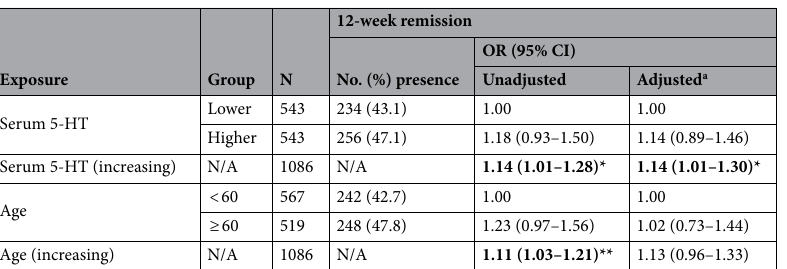
The individual effects of base- line serum 5-HT level and age on 12-week remission are shown in Table 2. As a binary variable, a high baseline serum 5-HT level was not significantly associated with the 12-week remission rate, whereas as a continuous